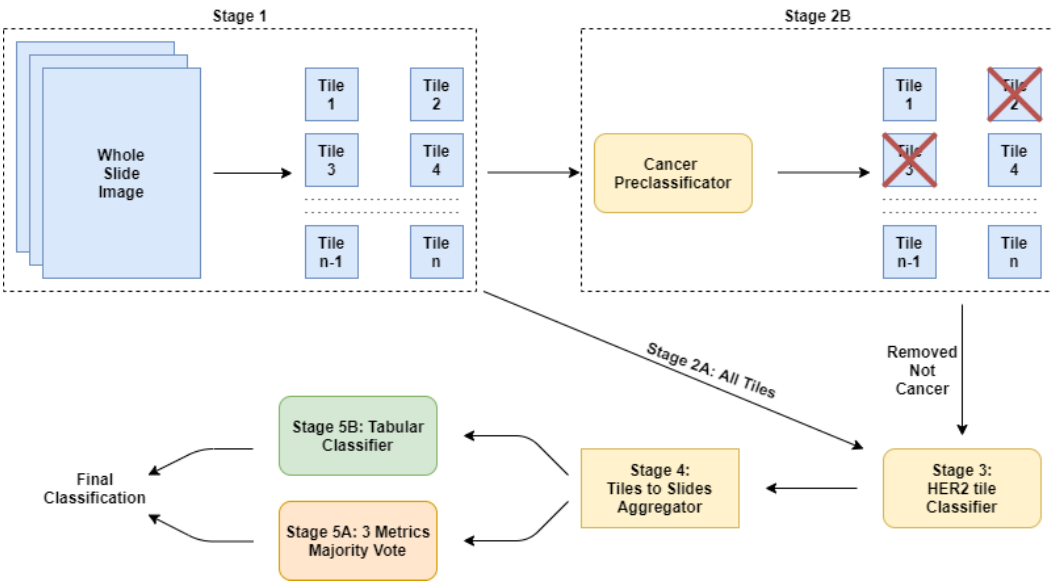
Figure 2. Graphical overview of the multi-stage deep learning